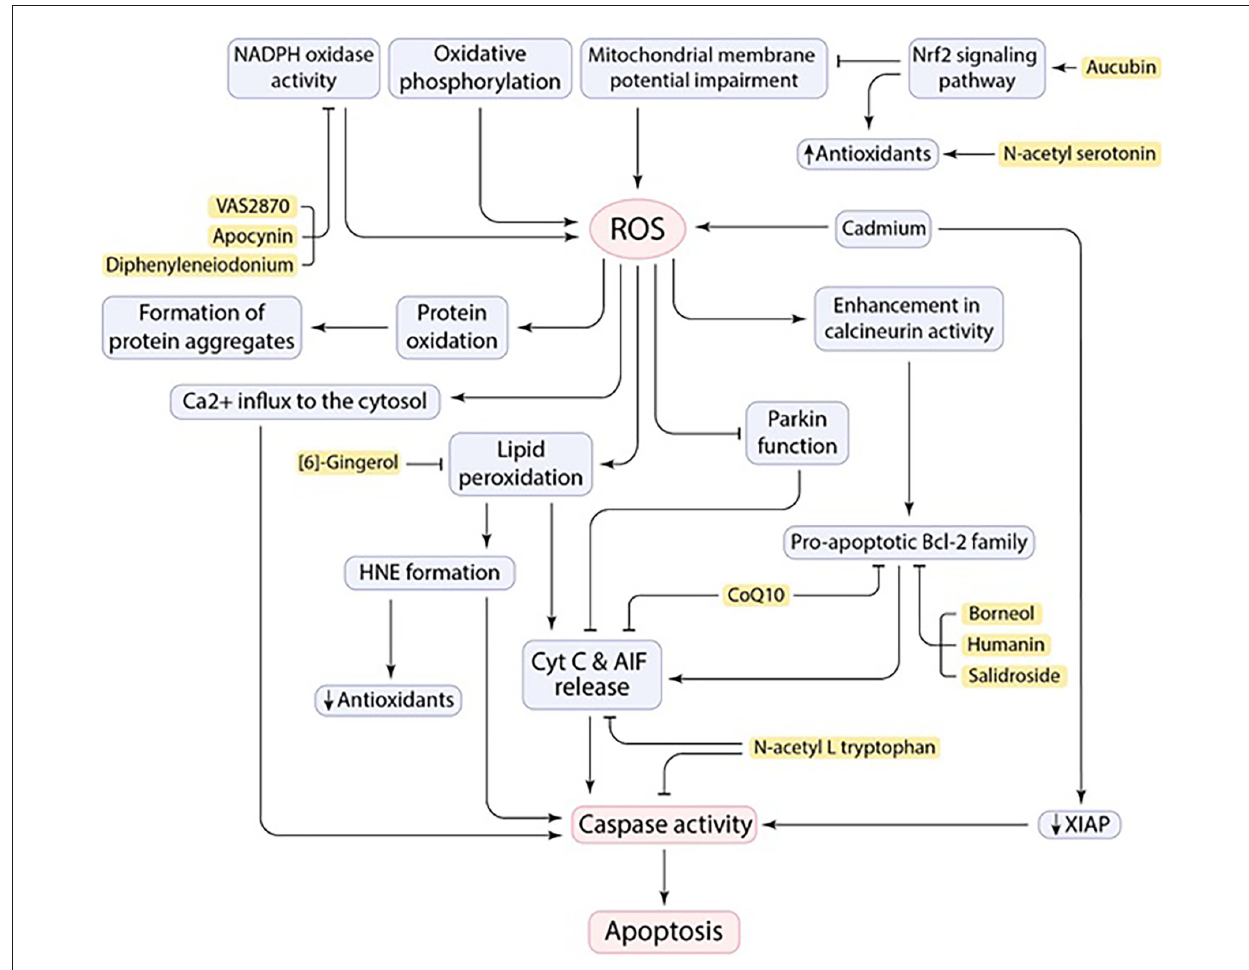
FIGURE2 Cause and consequences of ROS production in the CNS and the neuroprotective effects of inhibitory factors (shown in yellow